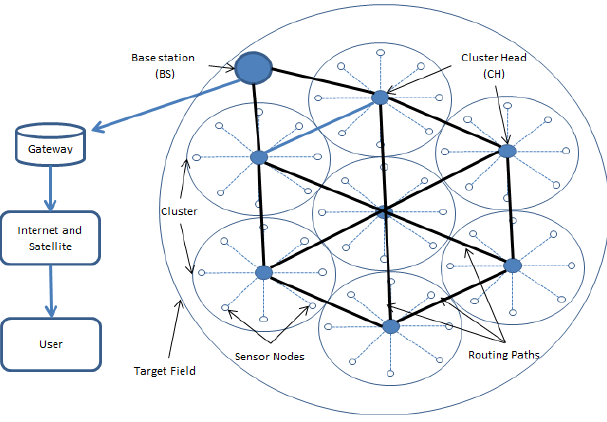
Figure 2. Cluster Architecture of WSN [7]